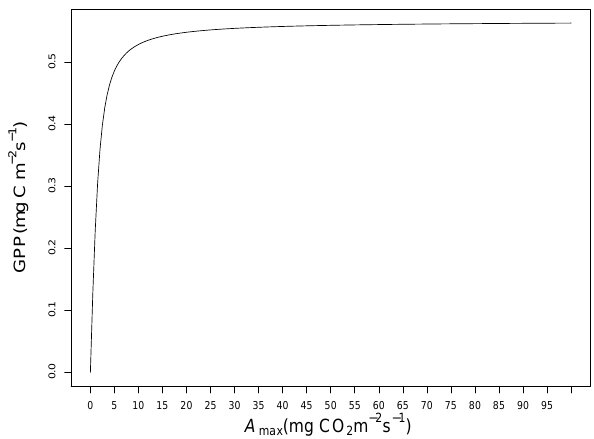
Figure 8. Variation of gross primary production (GPP) with the variation of photosynthetic capacity ( A max ) from 0 to 100mgCO 2 m − 2 s − 1 . The values of quantum yield ( α ), degree of curvature ( θ ), ecosystem respiration at reference temperature ( r 0 ), and temperature sensitive parameter ( k T ) are fixed at 0.7, 0.0022, 0.1, 0.07 respectively. Air temperature ( T a ) and pho- tosynthetic photon flux density (PPFD) are fixed at 10 ◦ C and 900µmolquantam − 2 s − 1